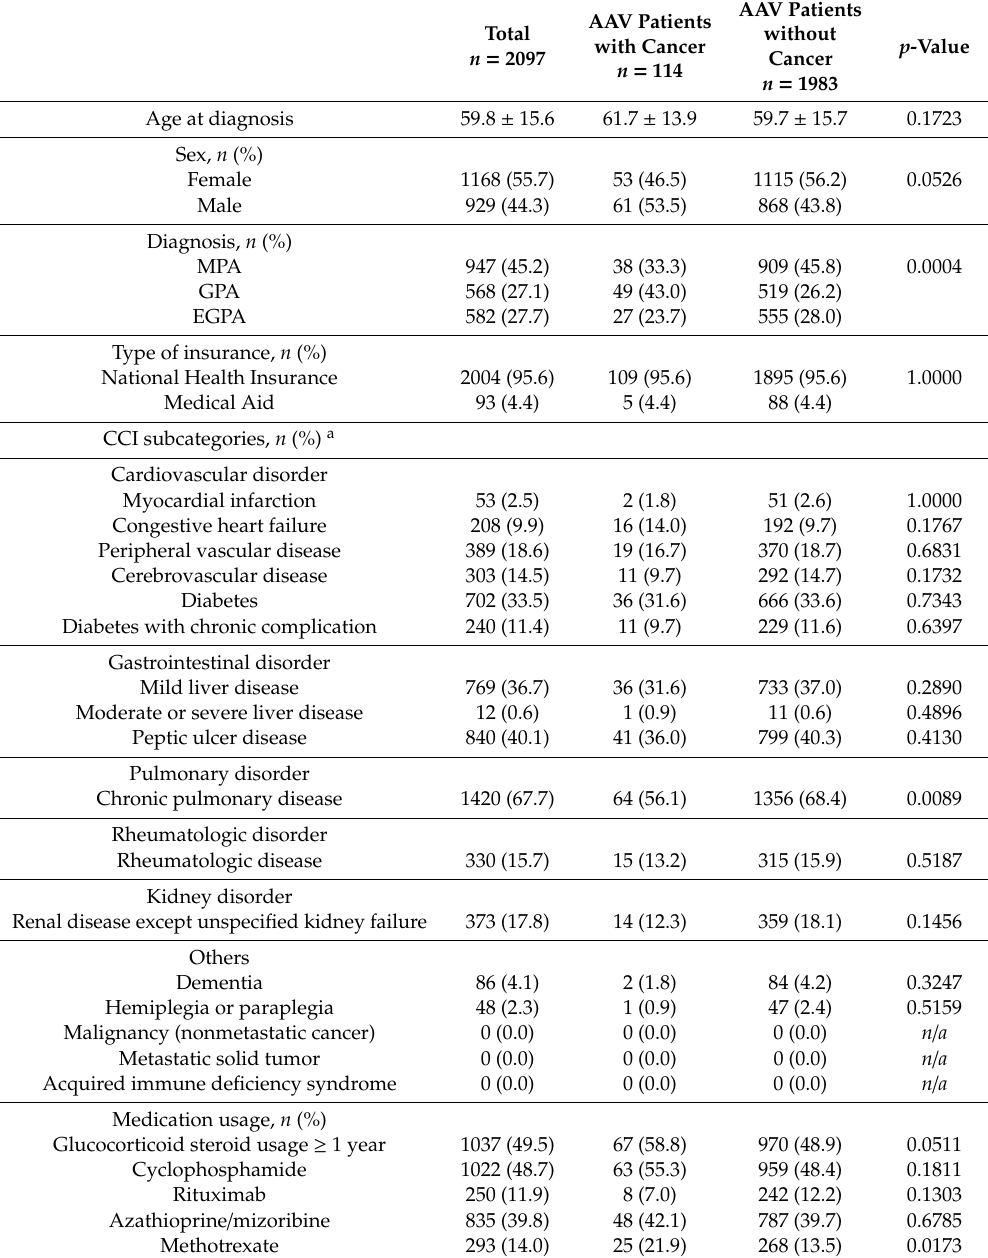
Table 1. Comparison of clinical characteristics between AAV Patients with and without